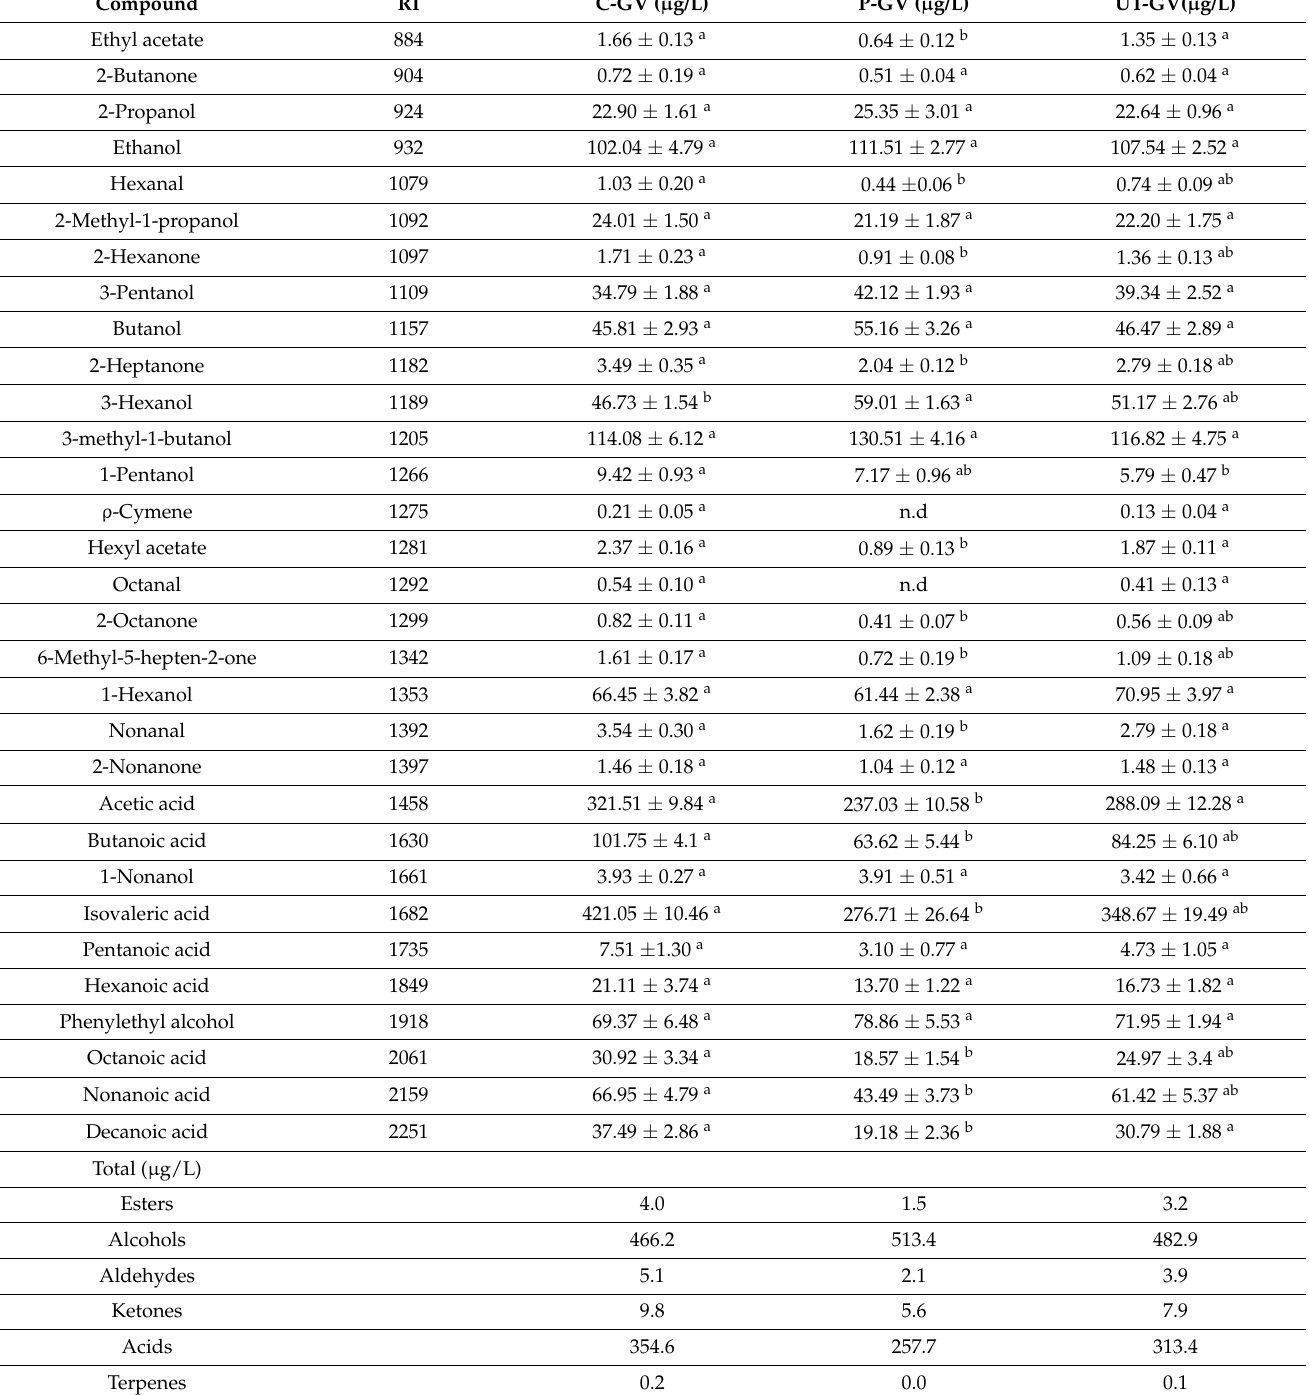
Table 9. Determination of volatile profiles of C-GV, P-GV, and